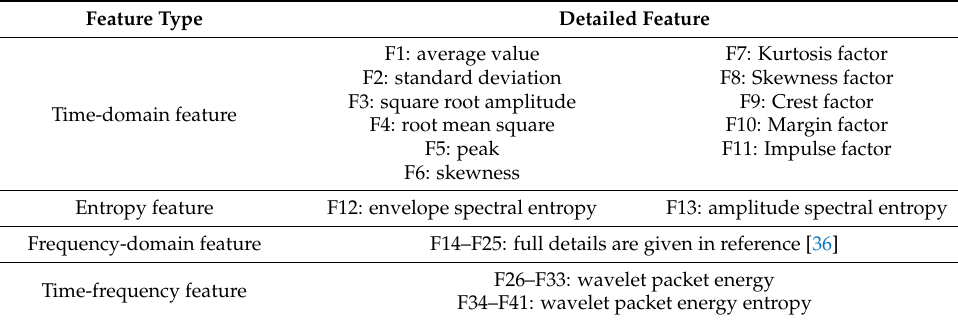
Figure 6. The whole lifetime RMSs of B1 and B2. Table 3. 41-Dimension features.